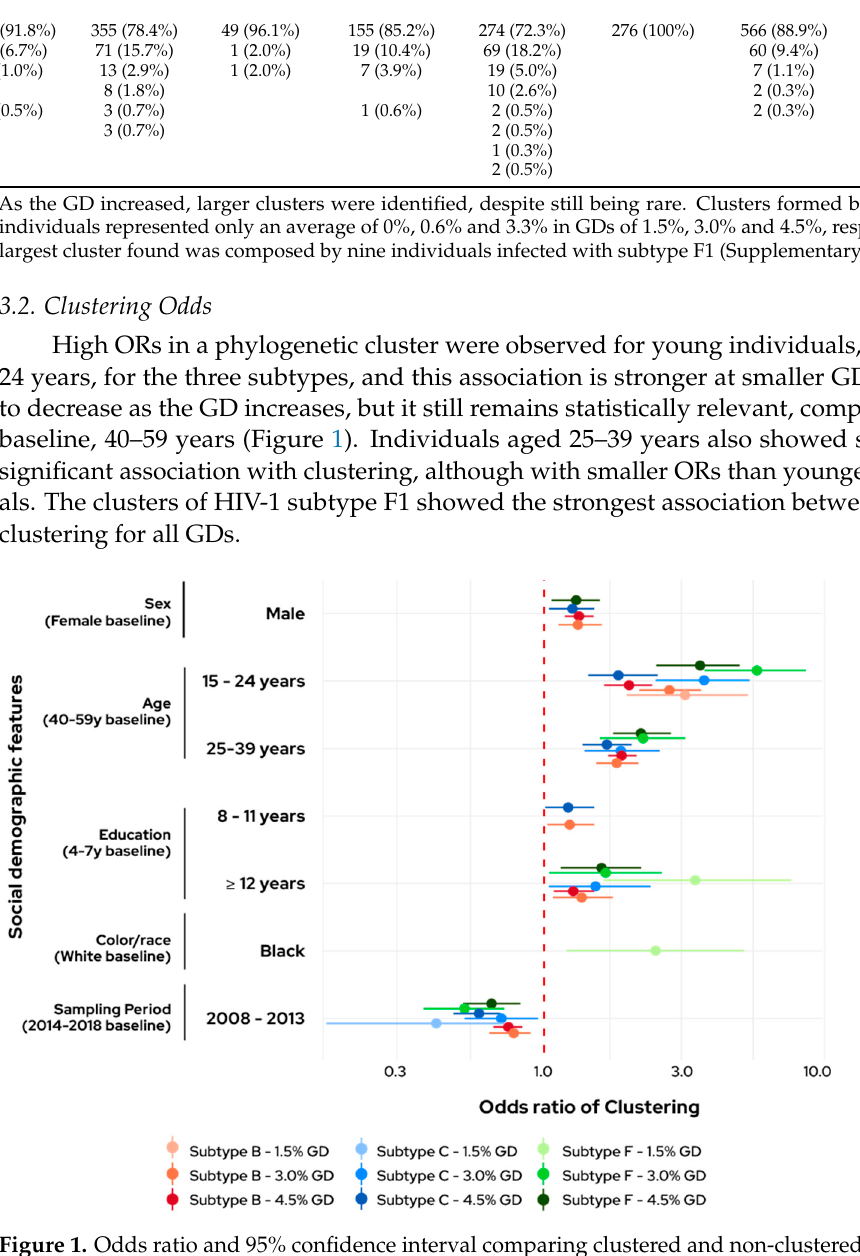
Figure 1. Odds ratio and 95% confidence interval comparing clustered and non-clustered individuals. Only statistically significant ( p < 0.05) associations are shown. Only statistically significant ( p < 0.05) associations are